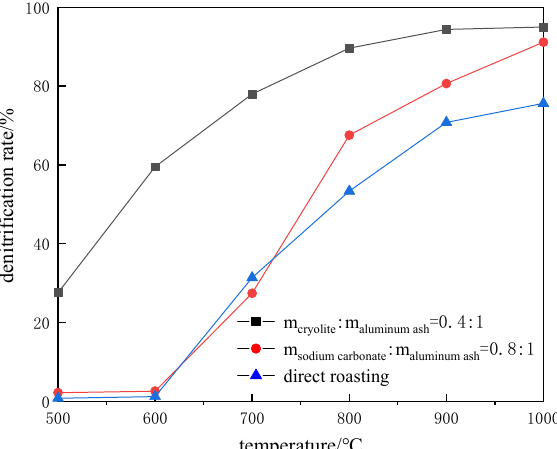
Figure 6. Effects of different temperatures on the nitrogen removal rate of high-nitrogen aluminum dross.